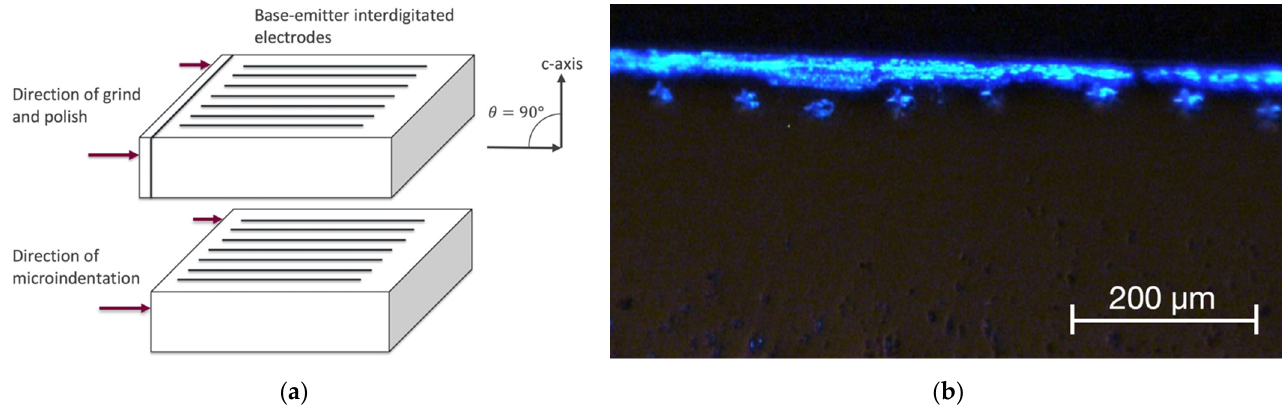
Figure 2. ( a ) A simplified diagram of the die structure to show grinding direction, viewing angle and indentation direction of Sample 1. ( b ) Optical microscopy image of Sample 1 after second-stage microindentation. The spectrum of Sample 1, as shown in Figure 3, indicates two strong peaks located at 390 and 445 nm and a long wavelength peak that is broadened and ranges from 480 nm to 500 nm, depending on the indentation condition.